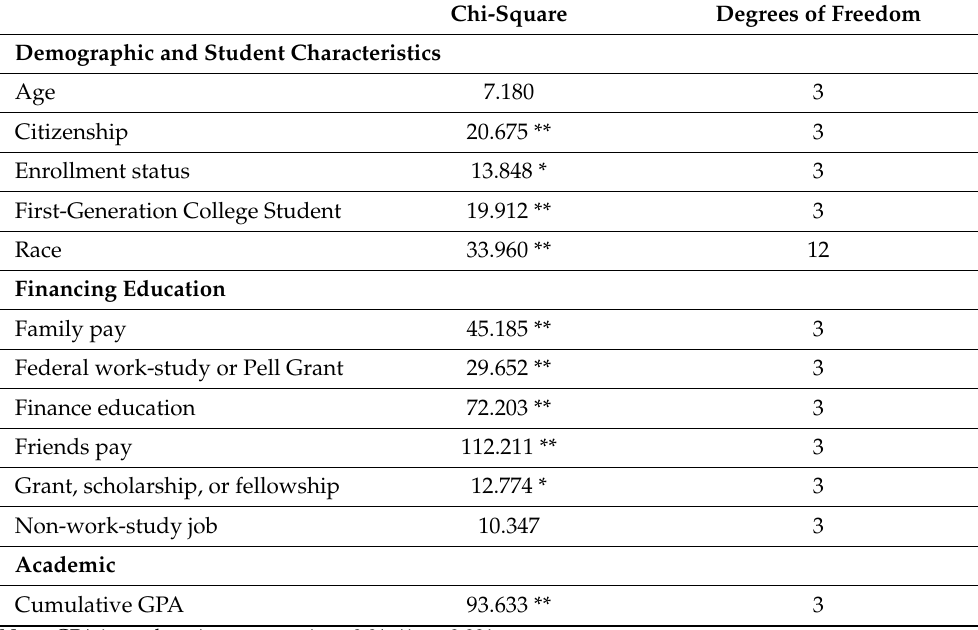
Table 3. Results of likelihood-ratio tests for the overall